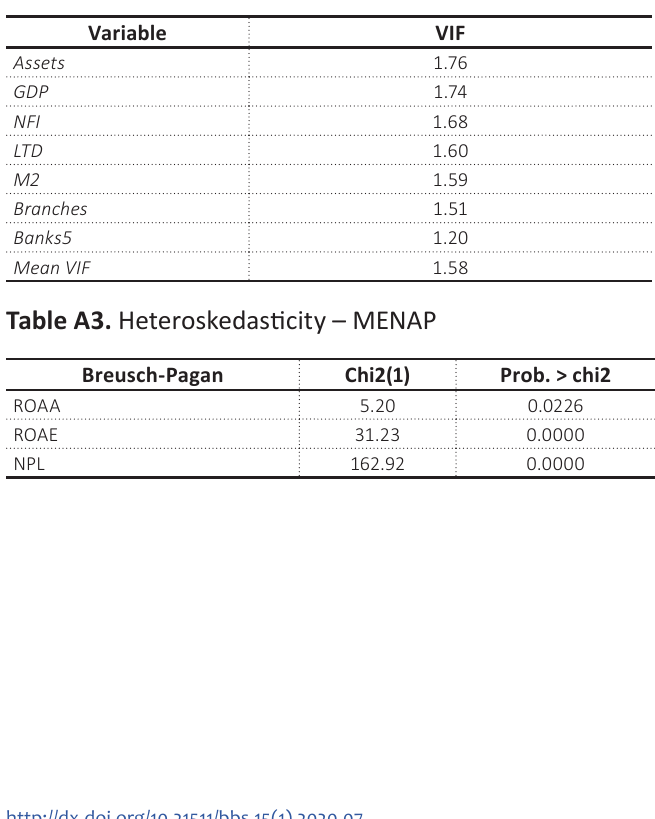
Table A2. Variance inflation factor – VIF-MENAP